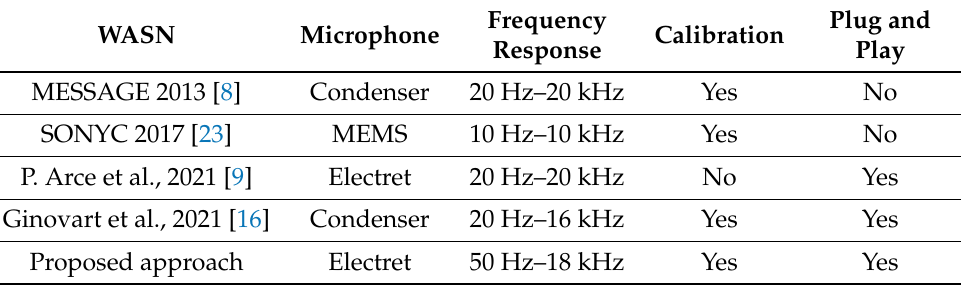
Table 6. Comparative table of different microphones implemented in each WASN. The last row represents the approach proposed in this